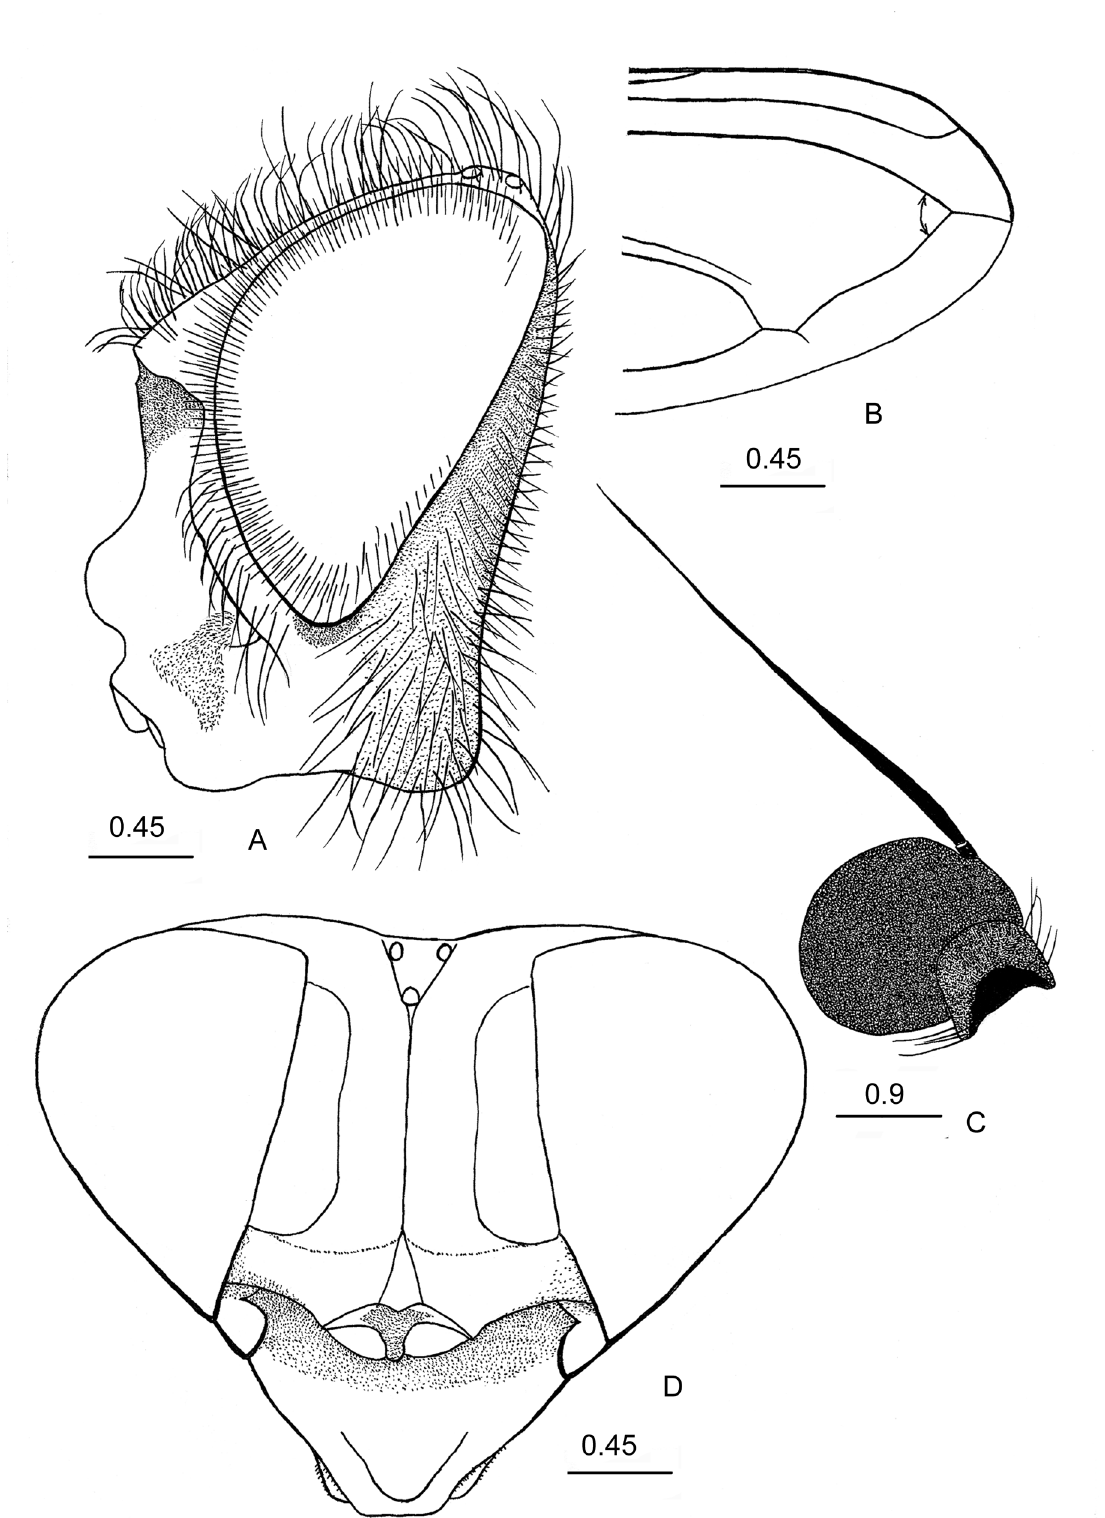
Fig. 9. Cheilosia ( Montanocheila ) brevimontana sp. nov., holotype, ♀ (ZSMC). A . Head, lateral view. B . Tip of wing. C . Antenna, lateral view of pedicel and basoflagellomere. D . Head, dorsal view. Scale bars indicated in